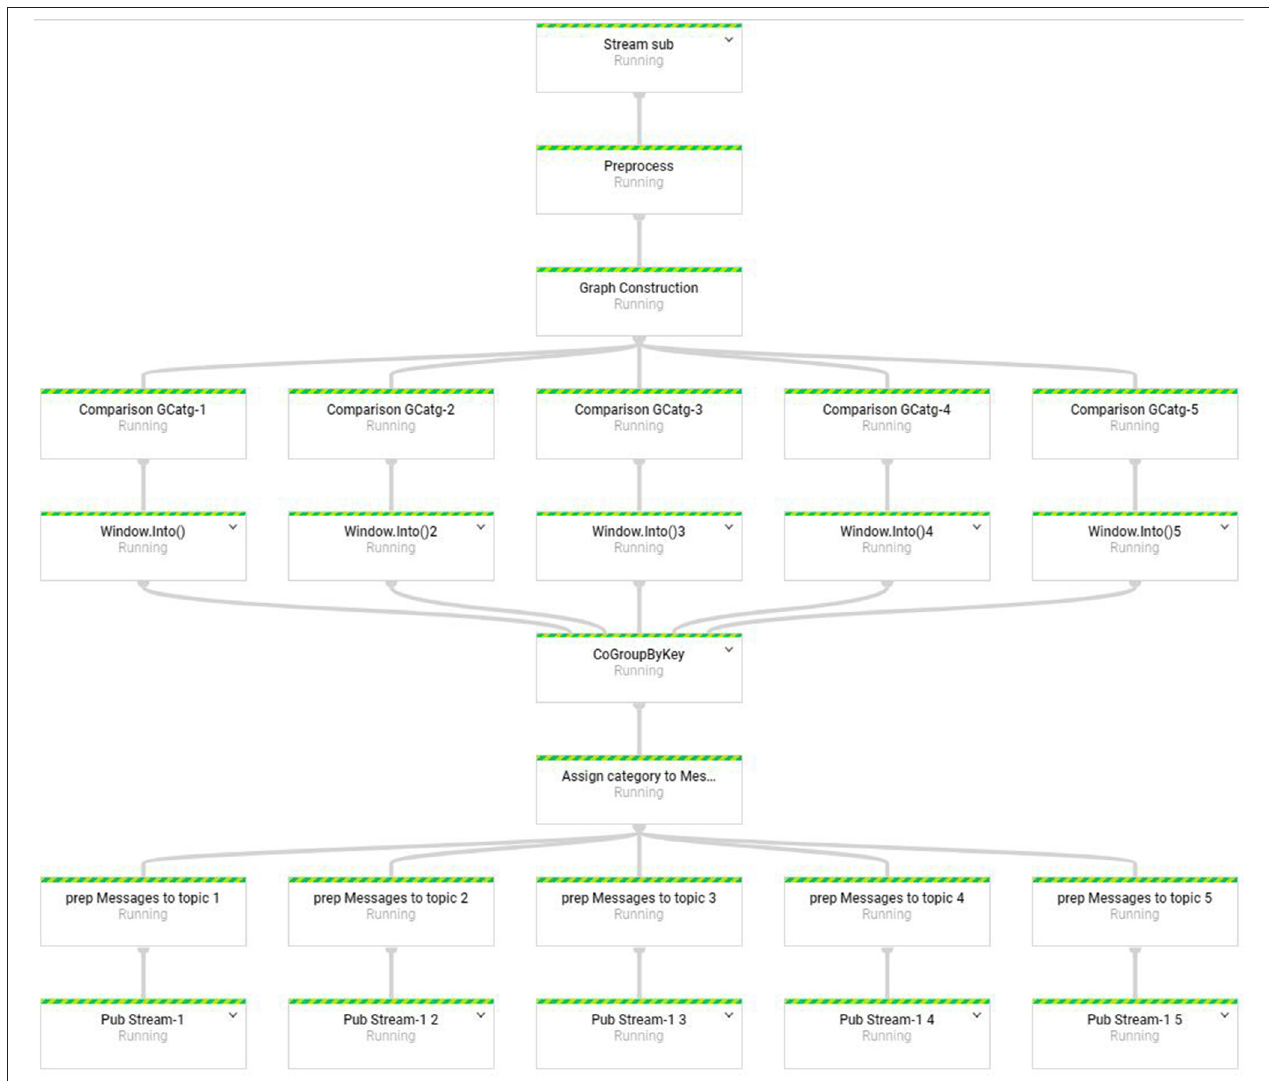
FIGURE 6 | NGG classification over HFDS